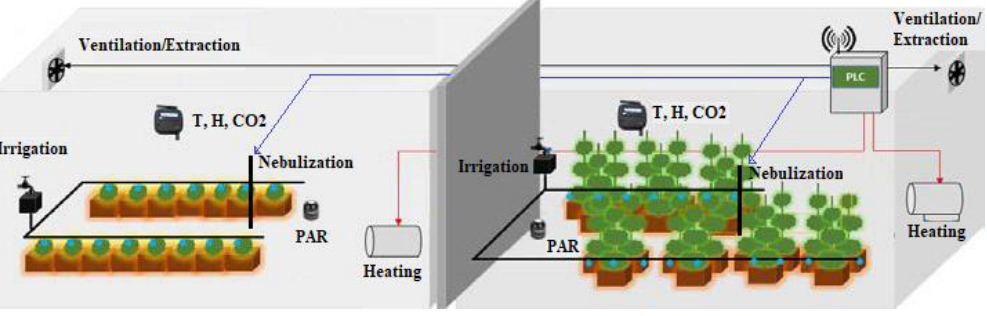
Figure 2. Sensors and actuators.